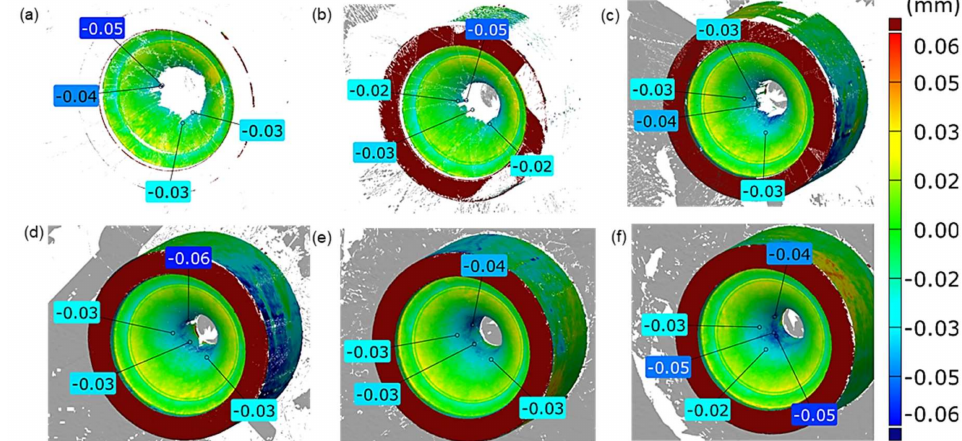
Figure 6. Measuring errors resulting from the change in the angle value between the normal direction and the reflected laser light in the process of filtering the measurement data a ff ecting the change of the area obtained for the analysis: ( a ) up to 20 ◦ , ( b ) up to 30 ◦ , ( c ) up to 40 ◦ , ( d ) up to 50 ◦ , ( e ) up to 60 ◦ , ( f ) up to 70 ◦